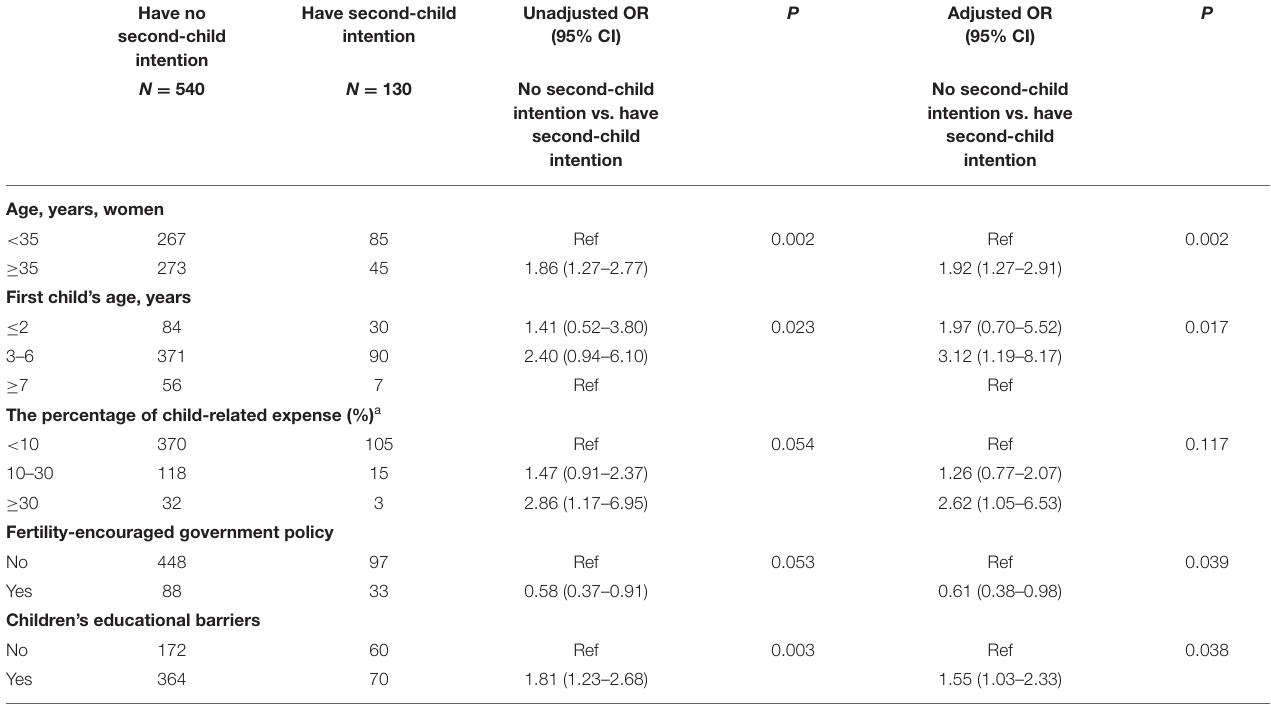
TABLE 3 | Factors associated with second-child